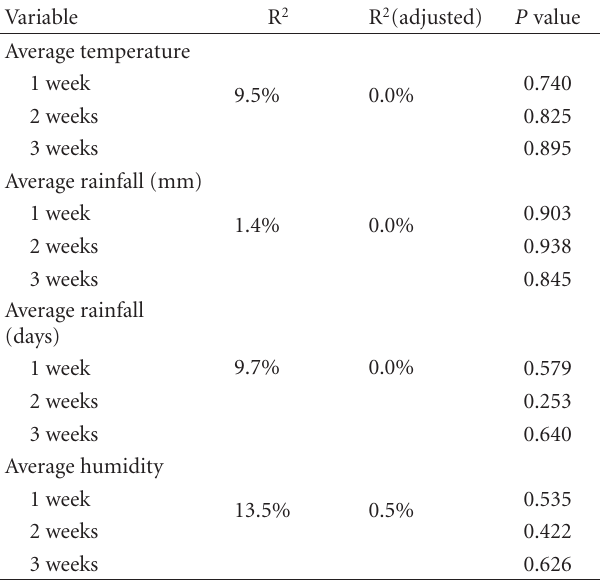
Table 4: Multiple-regression analysis among climate variables and sand flies yield from soil